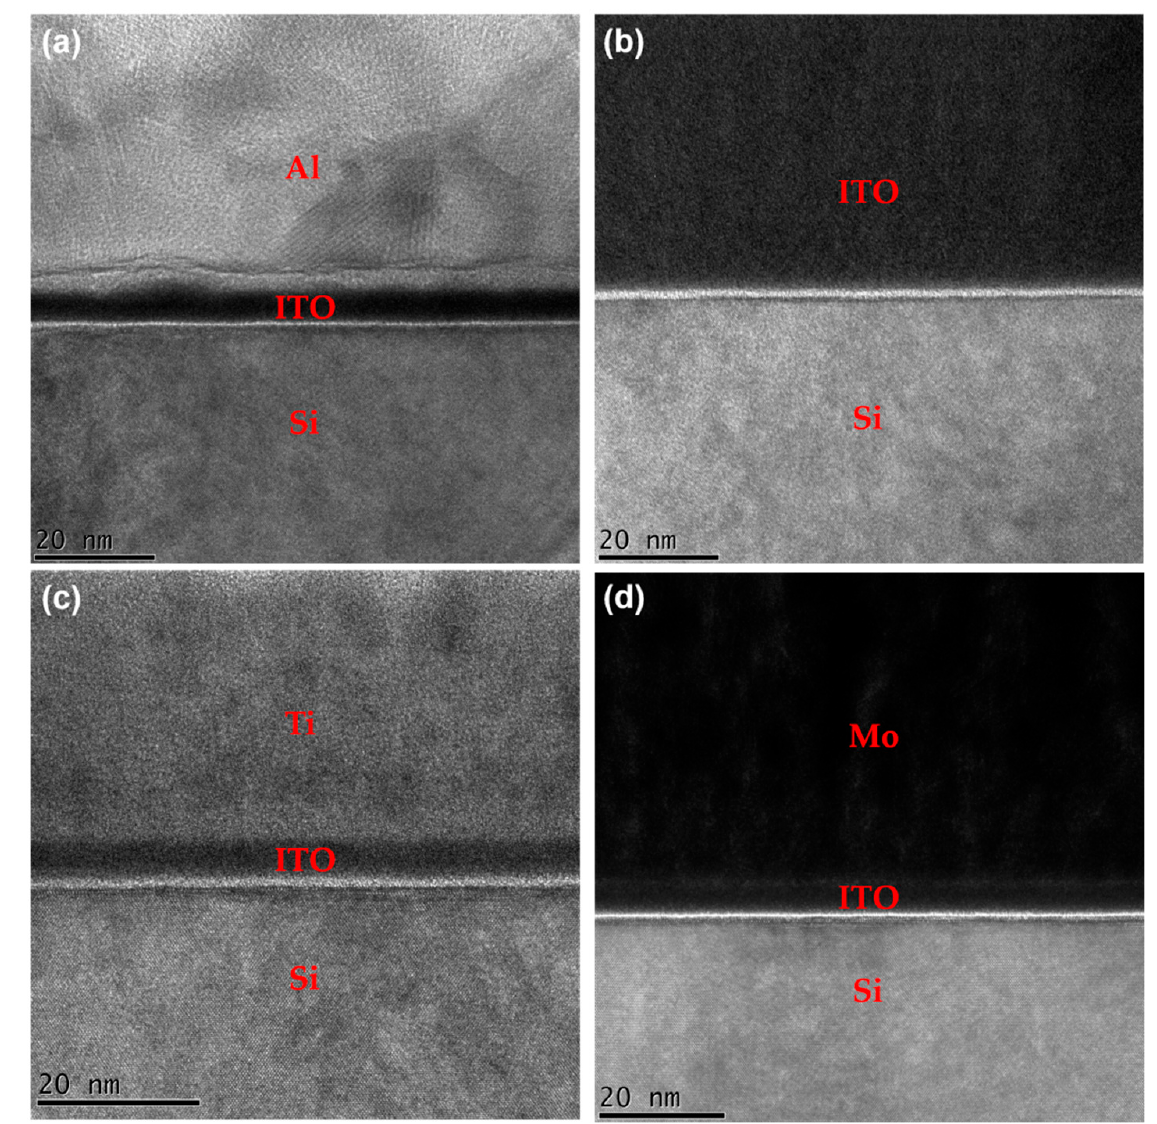
Figure 6. TEM images of the interfacial microstructures between ITO and the metal electrodes: ( a ) Al, ( b ) ITO, ( c ) Ti, and ( d )